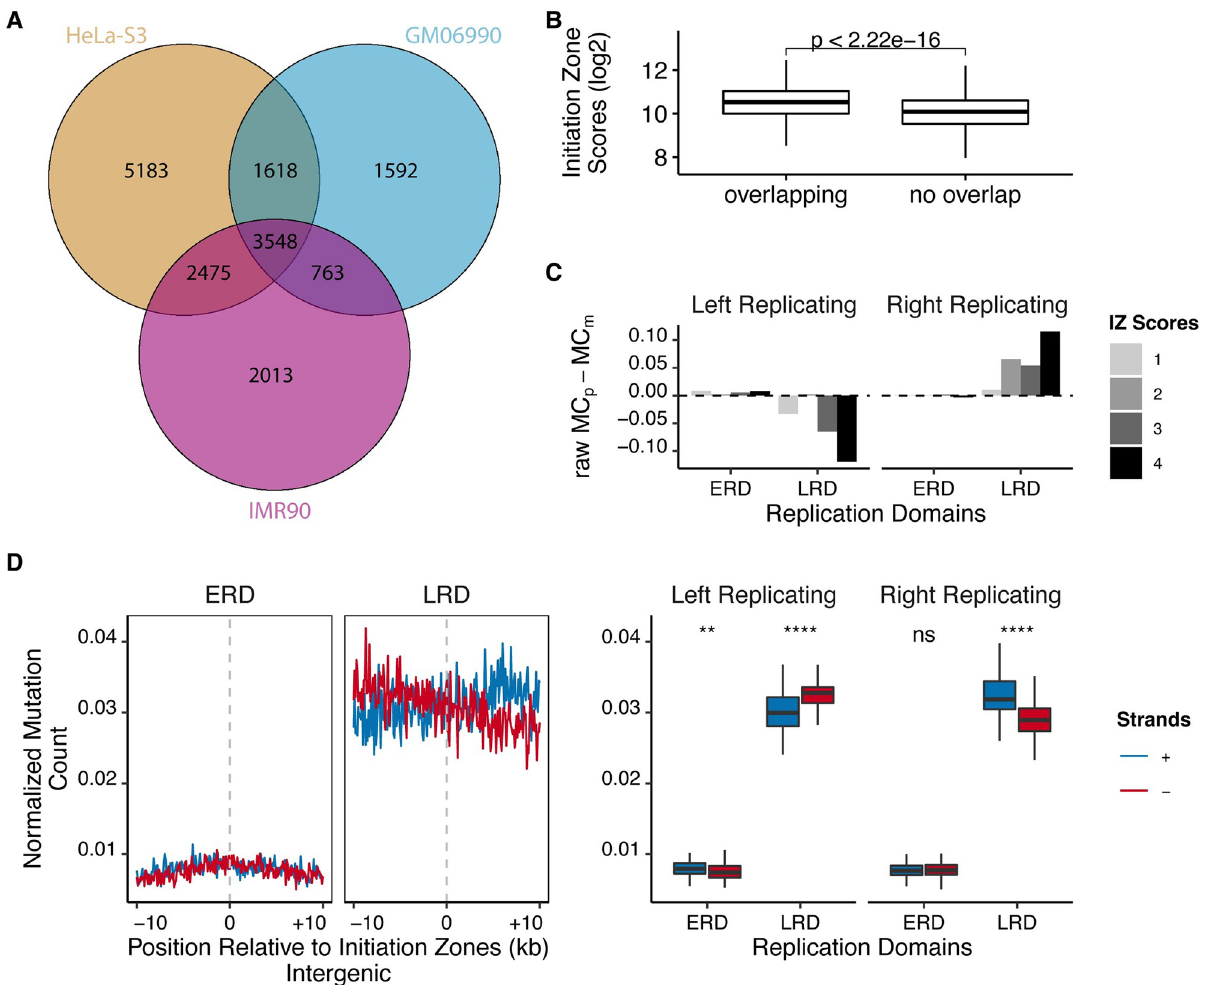
Fig 5. Melanoma mutation asymmetry around common replication initiation zones. (A) Venn diagram illustrating the shared initiation zones between HeLa, GM06990, and IMR90 cell lines. (B) Boxplots of HeLa initiation zones’ scores that are common in all 3 cell lines (overlapping) and the ones that are unique to HeLa cells (no overlap). The wilcoxon test was used to assess the significance of difference. (C) Common initiation zones (20 kb long in 200 windows) were separated into quartiles based on their scores (OK-seq slope values) for each replication domain, and absolute mutation count difference between strands were calculated. Quartiles 1 and 4 correspond to the lowest and highest initiation zone scores, respectively. (D) (Left) Normalized TC > TT and CC > CT mutations (MC: mutation per [TC]C per region) around initiation zones that were separated into corresponding replication domains. (Right) The boxplot of windows in left and right replicating directions are shown separately for plus and minus strands. Paired wilcoxon test was used to assess the significance of differences between the strands. Only mutations in intergenic regions were considered. Raw MC: not normalized mutation counts; MCp: mutation counts of plus strand; MCm: mutation counts of minus